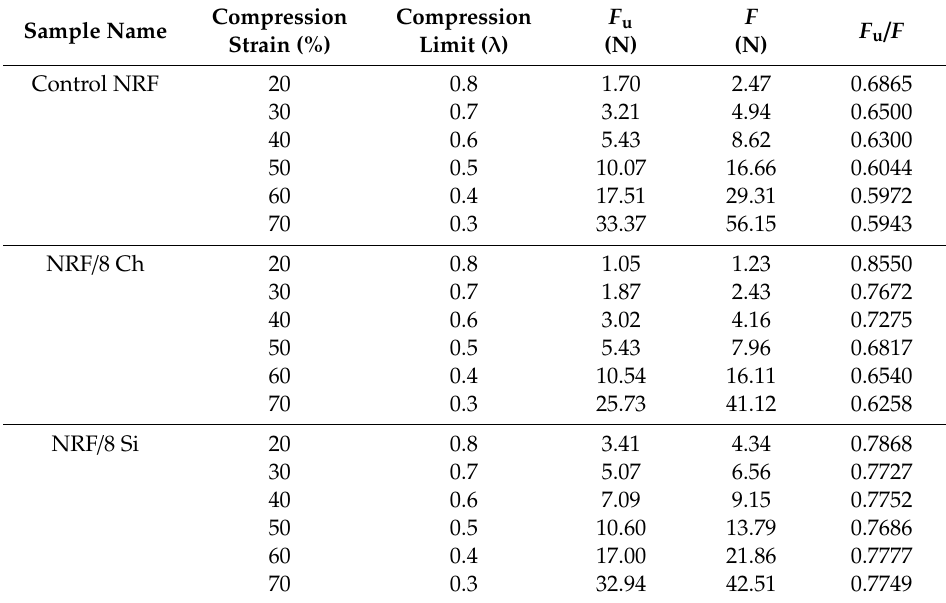
Table 3. Compression strain, compression limit, F u , F , and F u / F values of the control NRF and NRF with various fillers at 298.15